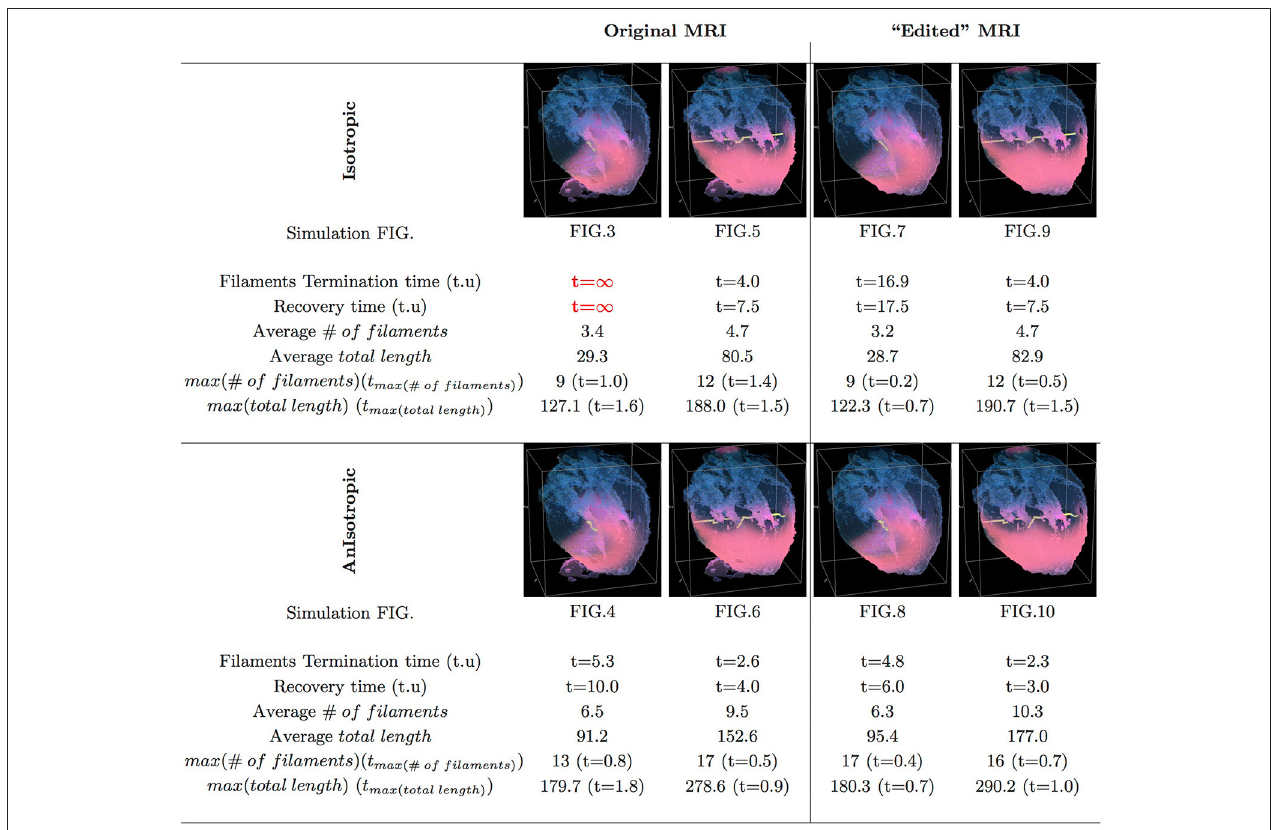
FIGURE 11 | Whole heart simulation: re-entry termination times. The translucent fetal heart is shown in blue, excitation front shown in red (see the color box in Figure 3 ), the yellow lines are the instant organizing filaments of the excitation vortices. Re-entry self-termination time in time units of Equations (1, 2) is shown under each simulation Figures 3 – 10 initiation panel. Comparison of the respective isotropic (top row) vs. anisotropic (bottom row) simulations shows that, regardless of with or without the “leftover” piece, anisotropy results in faster termination of re-entry, and at least twice shorter recovery time. Respective comparison of the original MRI with the corresponding “edited out leftover” simulations shows that the leftover “incidental capacitor” effect, depending of the re-entry location/orientation with respect to the “incidental capacitor” own location/orientation, might significantly prolongate cardiac re-entry life time. The bigger number and the total length of the filaments tend to correlate with the faster termination of re-entry, though these fail to identify persistent re-entry in Figure 3